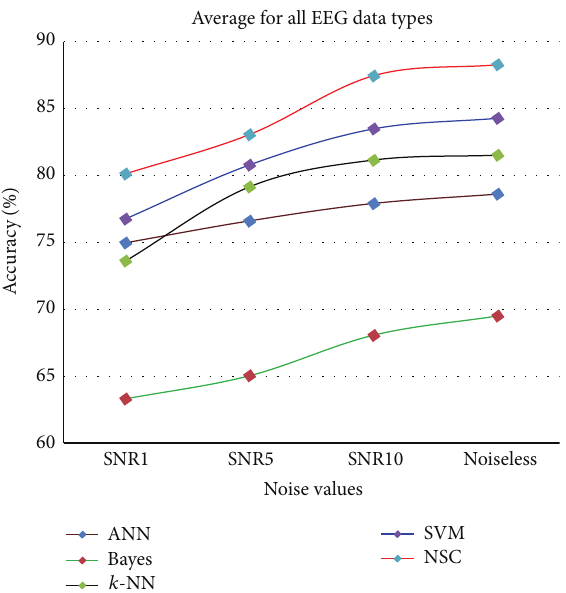
Figure 8: Average accuracy of classifiers for all CR values with SNR = 1, 5, and 10 dB and noiseless EEG